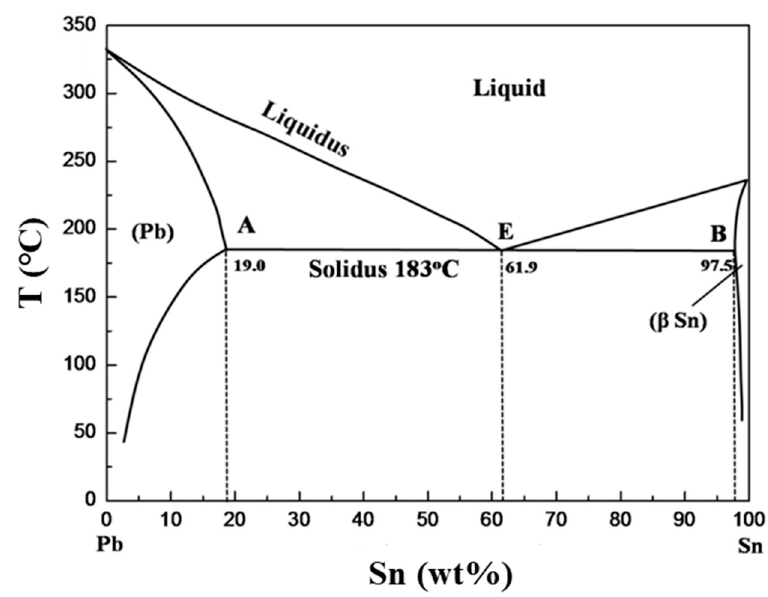
Figure 1. Sn–Pb binary alloy phase diagram.